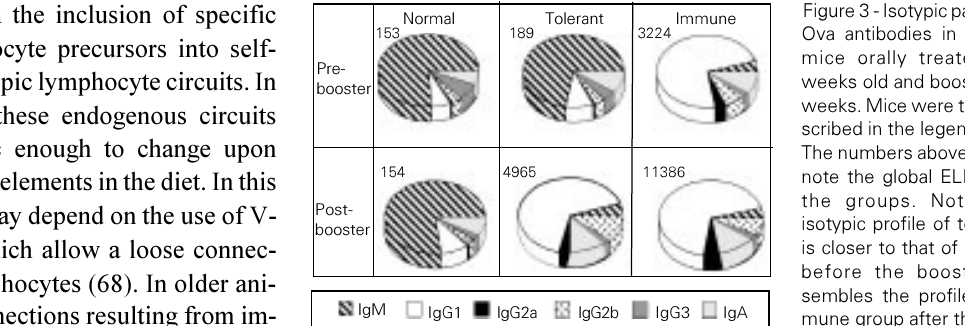
Figure 3 - Isotypic pattern of anti- Ova antibodies in 70-week-old mice orally treated when 8 weeks old and boosted after 52 weeks. Mice were treated as de- scribed in the legend to Table 1. The numbers above the pies de- note the global ELISA score of the groups. Note that the isotypic profile of tolerant mice is closer to that of normal mice before the booster and re- sembles the profile of the im- mune group after the